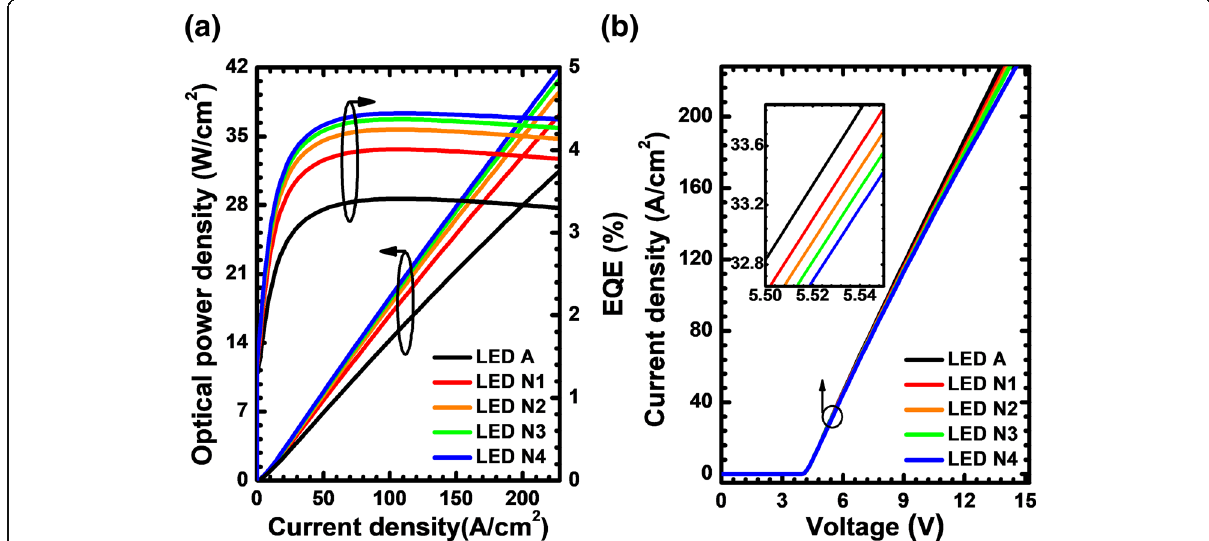
Fig. 13 a Optical output power density and EQE as a function of the injection current, b current-voltage characteristic for LEDs A, N1, N2, N3, and N4. Inset figure shows the zoom-in current-voltage